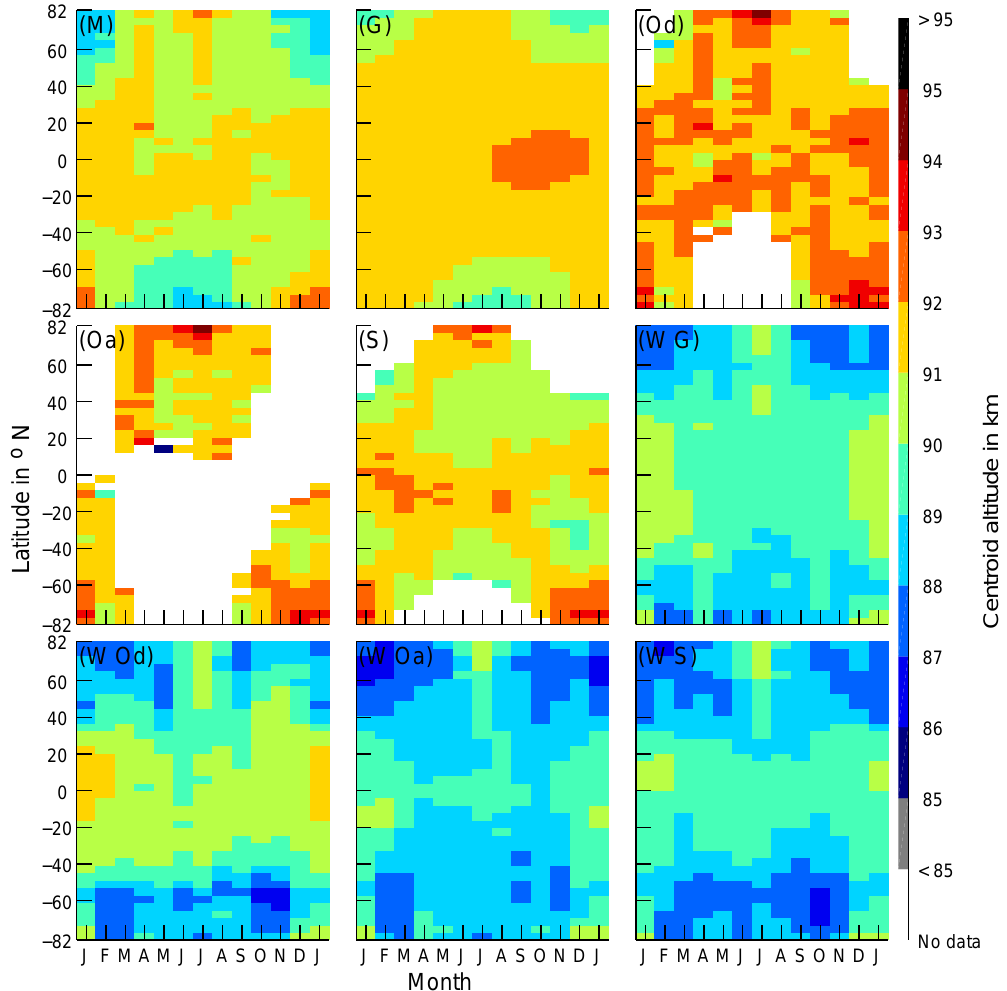
Figure 5. 2008–2012 multi-annual monthly mean Na layer centroid altitude from different instruments and models. Ensemble mean (M), GOMOS (G), OSIRIS descending leg (Od), OSIRIS ascending leg (Oa), SCIAMACHY dayglow (S), WACCM colocated with the LT of the ascending leg of GOMOS (W G), WACCM colocated with the LT of the descending leg of OSIRIS (W Od), WACCM colocated with the LT of the ascending leg of OSIRIS (W Oa), WACCM colocated with the dayglow measurements of SCIAMACHY and the descending leg of GOMOS (W